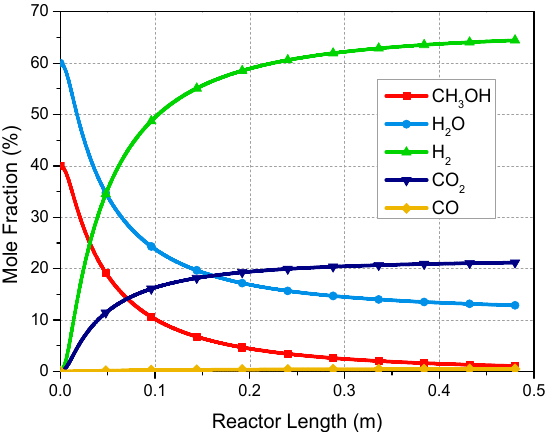
Figure 7. Profiles of mole fraction of each components along the length of reactor.